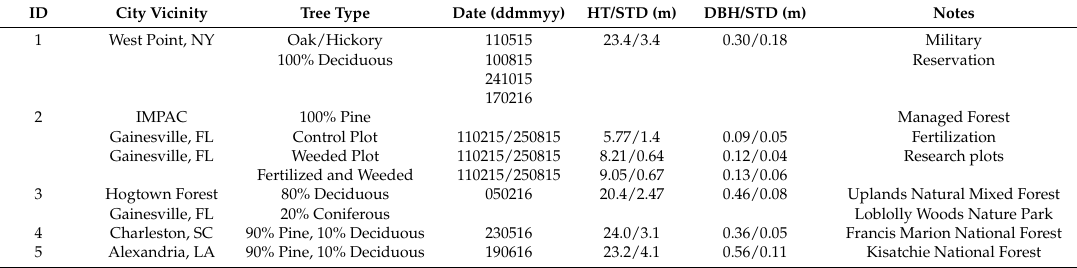
Table 1. Forest study sites and